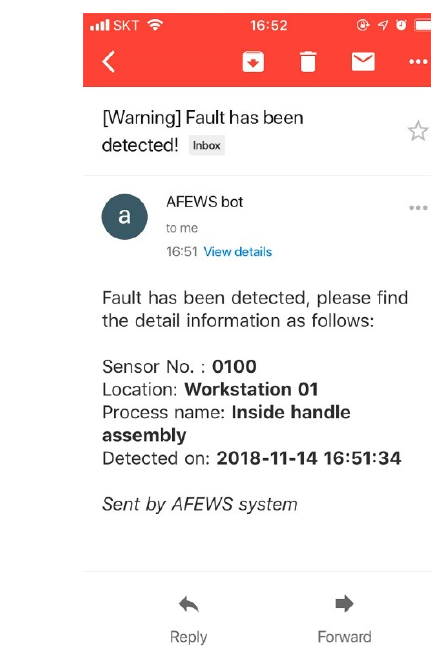
Figure 7. AFEWS web dashboard.